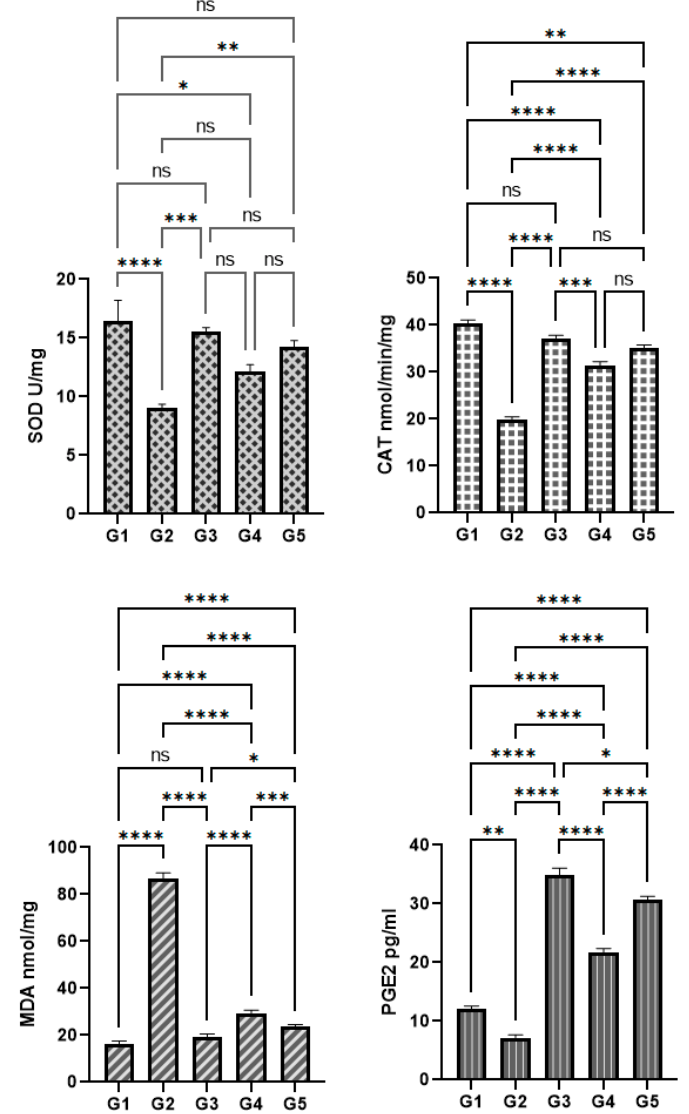
Figure 8. Influences of the PDE on SOD, CAT, PGE2, and MDA levels in stomach tissue homogenates of the ethanol-induced ulcerogenic rats. G1, normal control; G2, ulcer control; G3, reference rats (omeprazole, 20 mg/kg); G4, rats received 200 mg/kg of the PDE; G5, rats received 400 mg/kg of the PDE. Data are expressed as means ± SEM ( n = 6). The significant levels are presented as *, p < 0.05; **, p < 0.01; ***, p < 0.001; ****, p < 0.0001 .